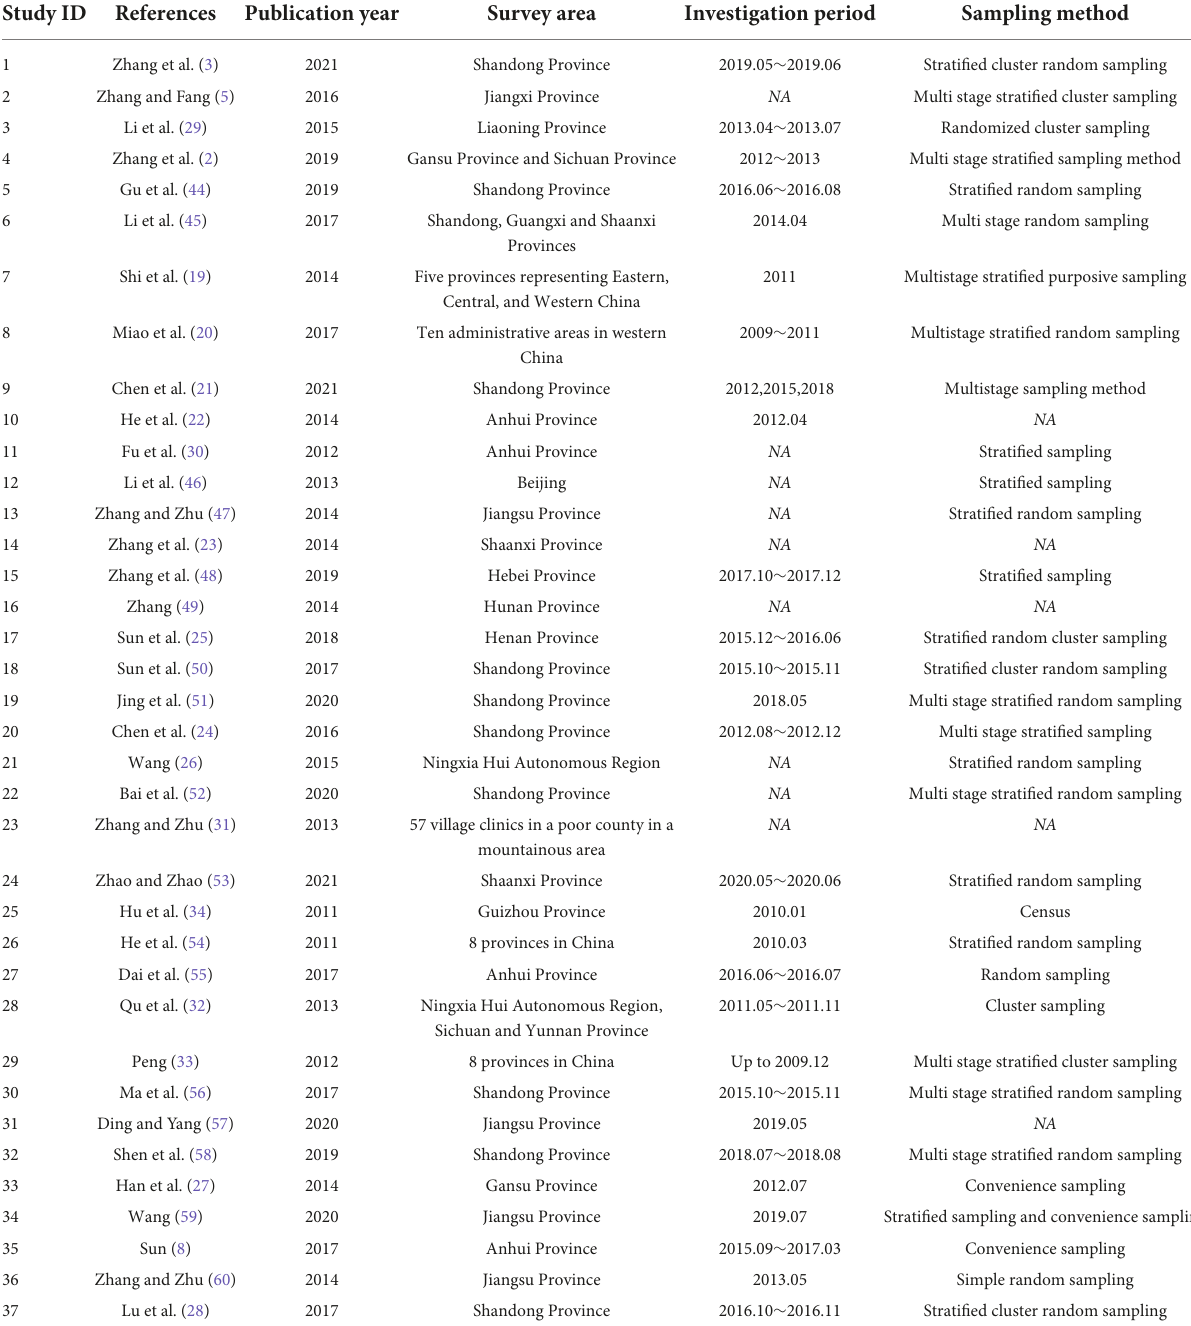
TABLE 1 Characteristic of 37 included studies of the status of Chinese village doctors’ job